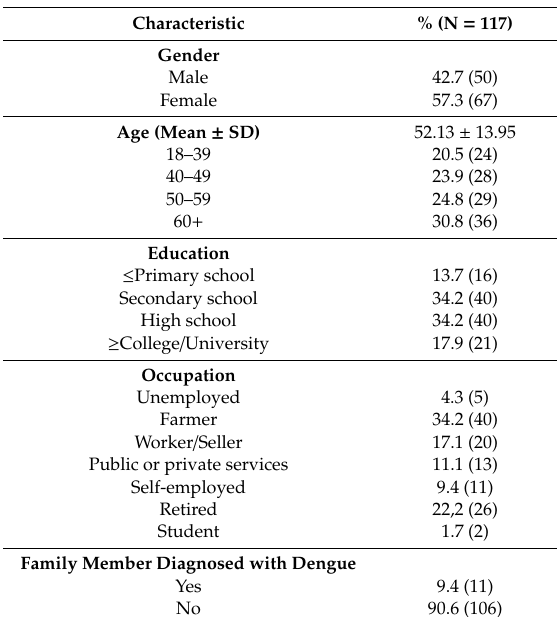
Table 1. Socio-demographic profile of participants.